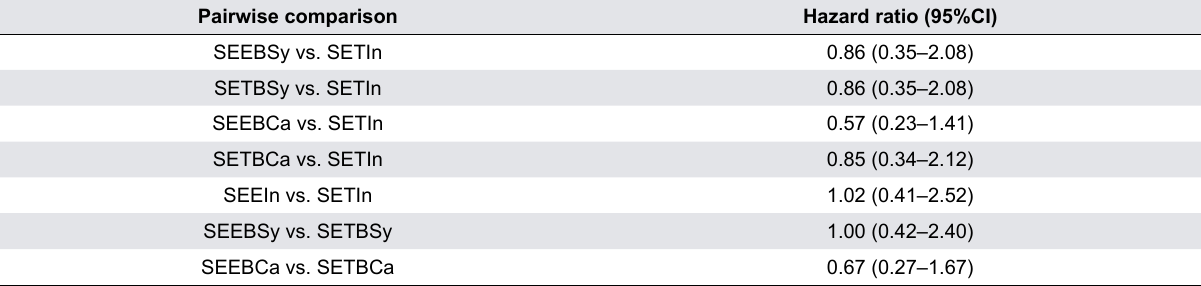
BARCELEIRO MO, TARDEM C, ALBUQUERQUE EG, LOPES LS, MARINS SS, POUBEL LA, BARCELOS R, ÑAUPARI-VILLASANTE R, LOGUERCIO AD, CALAZANS Table 4- Fracture and retention loss hazard ratio (95%CI) for pairwise comparison of different groups